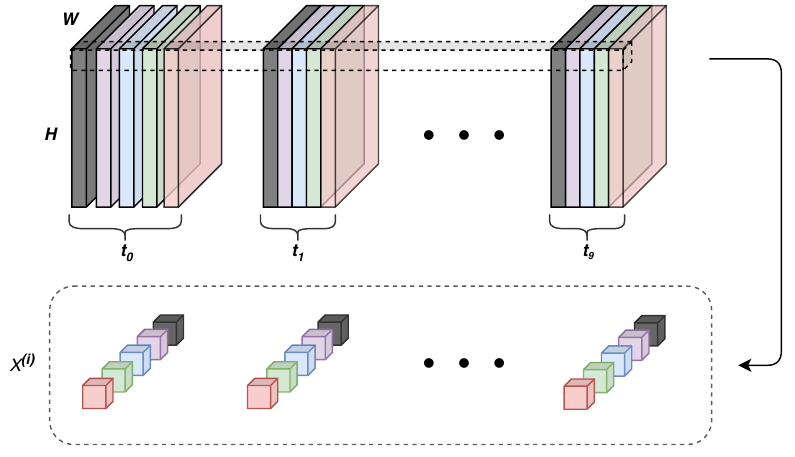
Figure 8. Overview of the tensor X ∈ R i × t × b generation. The first dimension i represents the collected instances X ( i ) , the second t the different time steps, and finally the last one b the five spectral bands, red, green, blue, near-infrared and NDVI. On the top, labeled pixels are extracted simultaneously, from all-time steps and bands starting from the raw satellite images. Then, X i , j , k are reshaped in order to set up the X ( i ) = X i ,:,: of the data set tensor X